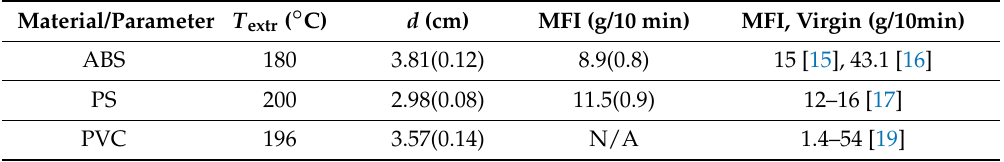
Table 1. Parameters of extruded filaments for recycled samples and their virgin counterparts found in the